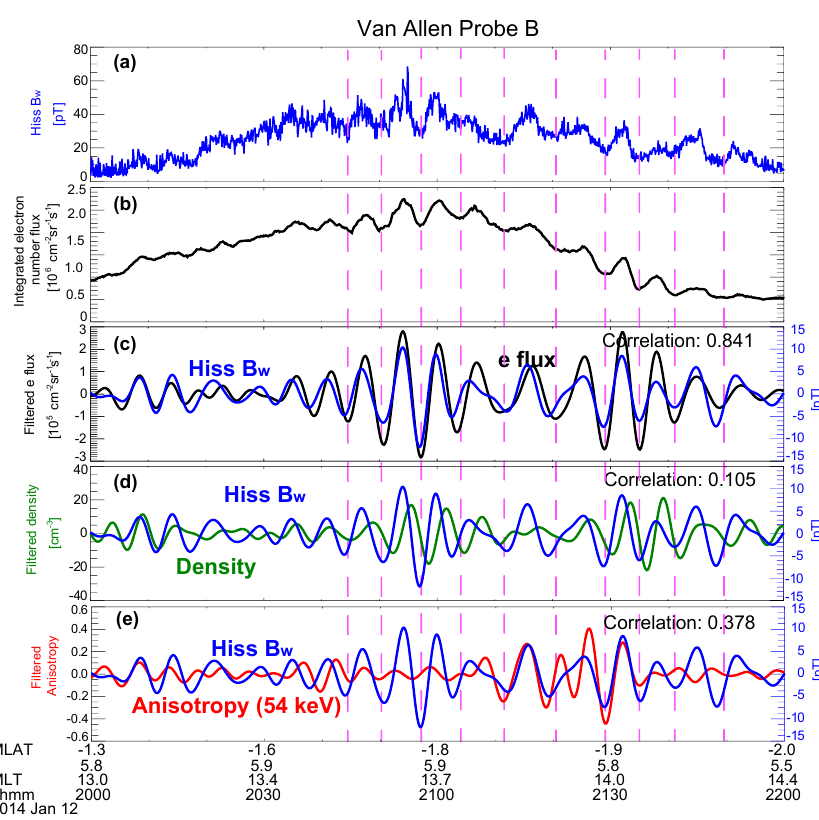
Figure 2. (a) Integrated hiss intensity from 20 to 1000Hz; (b) integrated spin-averaged electron flux from 30 to 200keV; (c) filtered integrated electron number flux (black) and filtered magnetic wave intensity of hiss (blue); (d) filtered plasma density (green) and filtered magnetic wave intensity of hiss (blue); (e) filtered pitch angle anisotropy (red) and filtered magnetic wave intensity of hiss (blue). The vertical dashed lines depict the same times as those in Fig.